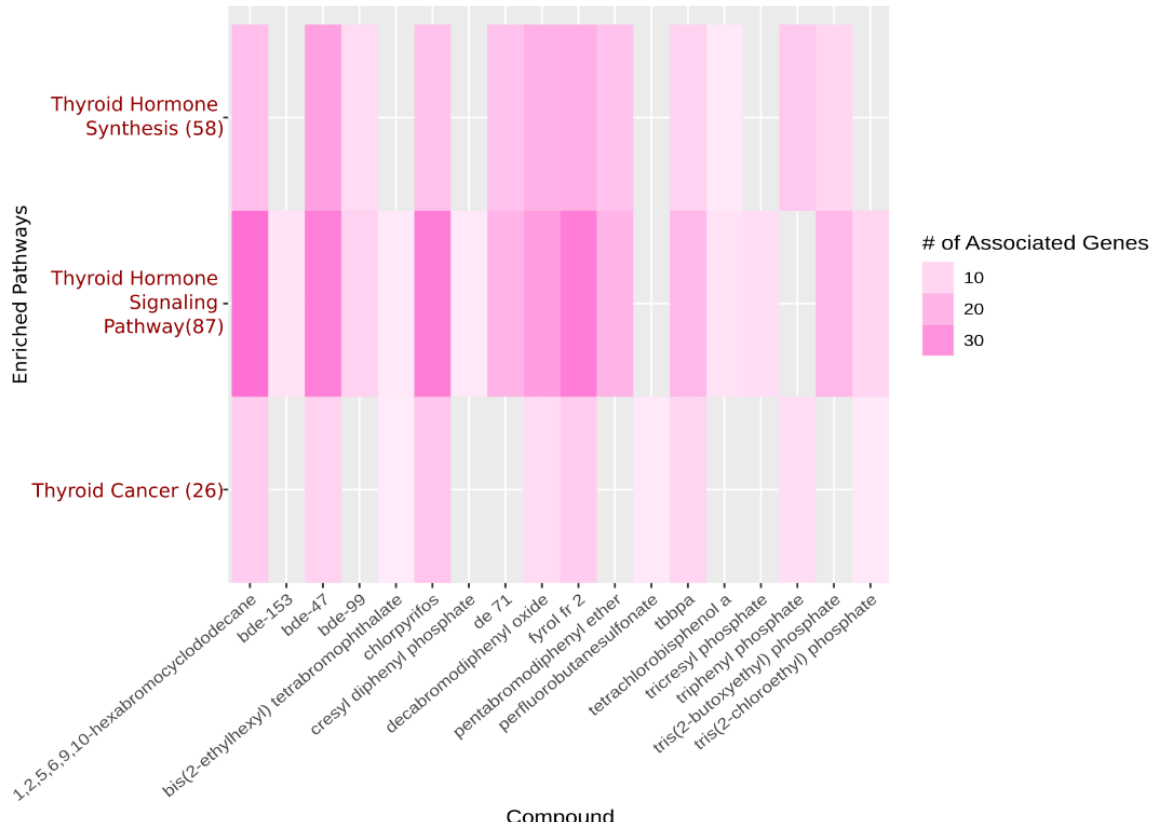
Figure 2. A heatmap displaying a pathway enrichment analysis done on CTD using FRCs that were used in a high throughput screening experiment. Individual FRCs are plotted along the x -axis. The y -axis lists the pathways that are enriched for these chemicals, with the number in parentheses indicating the number of genes in each pathway that these chemicals (taken as a whole) are enriched in. Darker coloration represents increasing numbers of genes that are associated with each FRC.